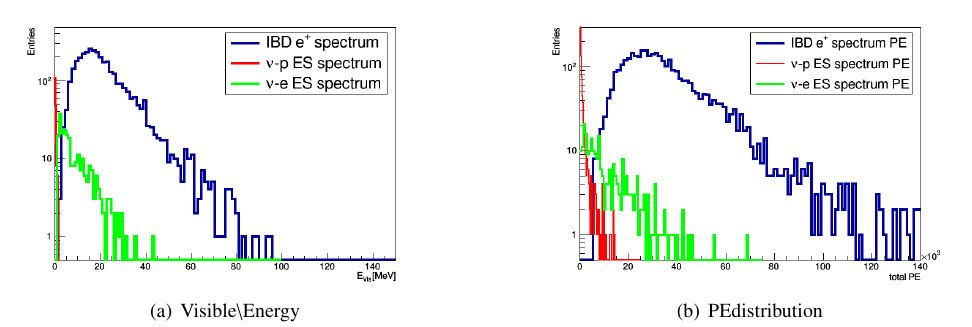
Figure 1. Left: Distribution of the energy spectra as a function of the visible energy for IBD (blue), ν − p ES (red) and ν − e ES (green). Right: distribution of the NPE for the IBD (blue), ν − p ES (red) and ν − e ES